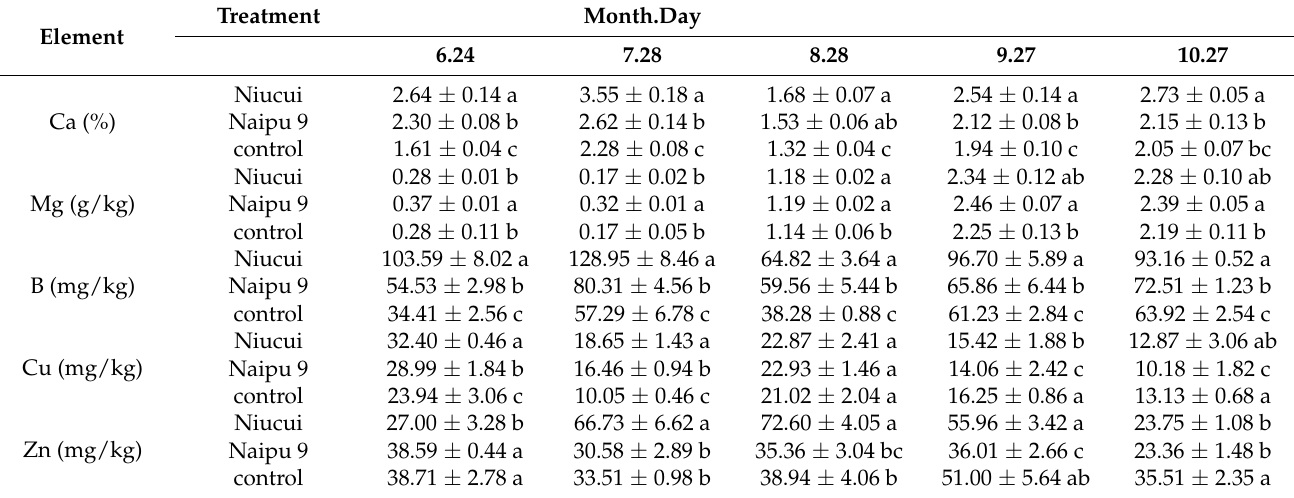
Table 3. Effects of spraying calcium fertilizer on mineral element content of apple